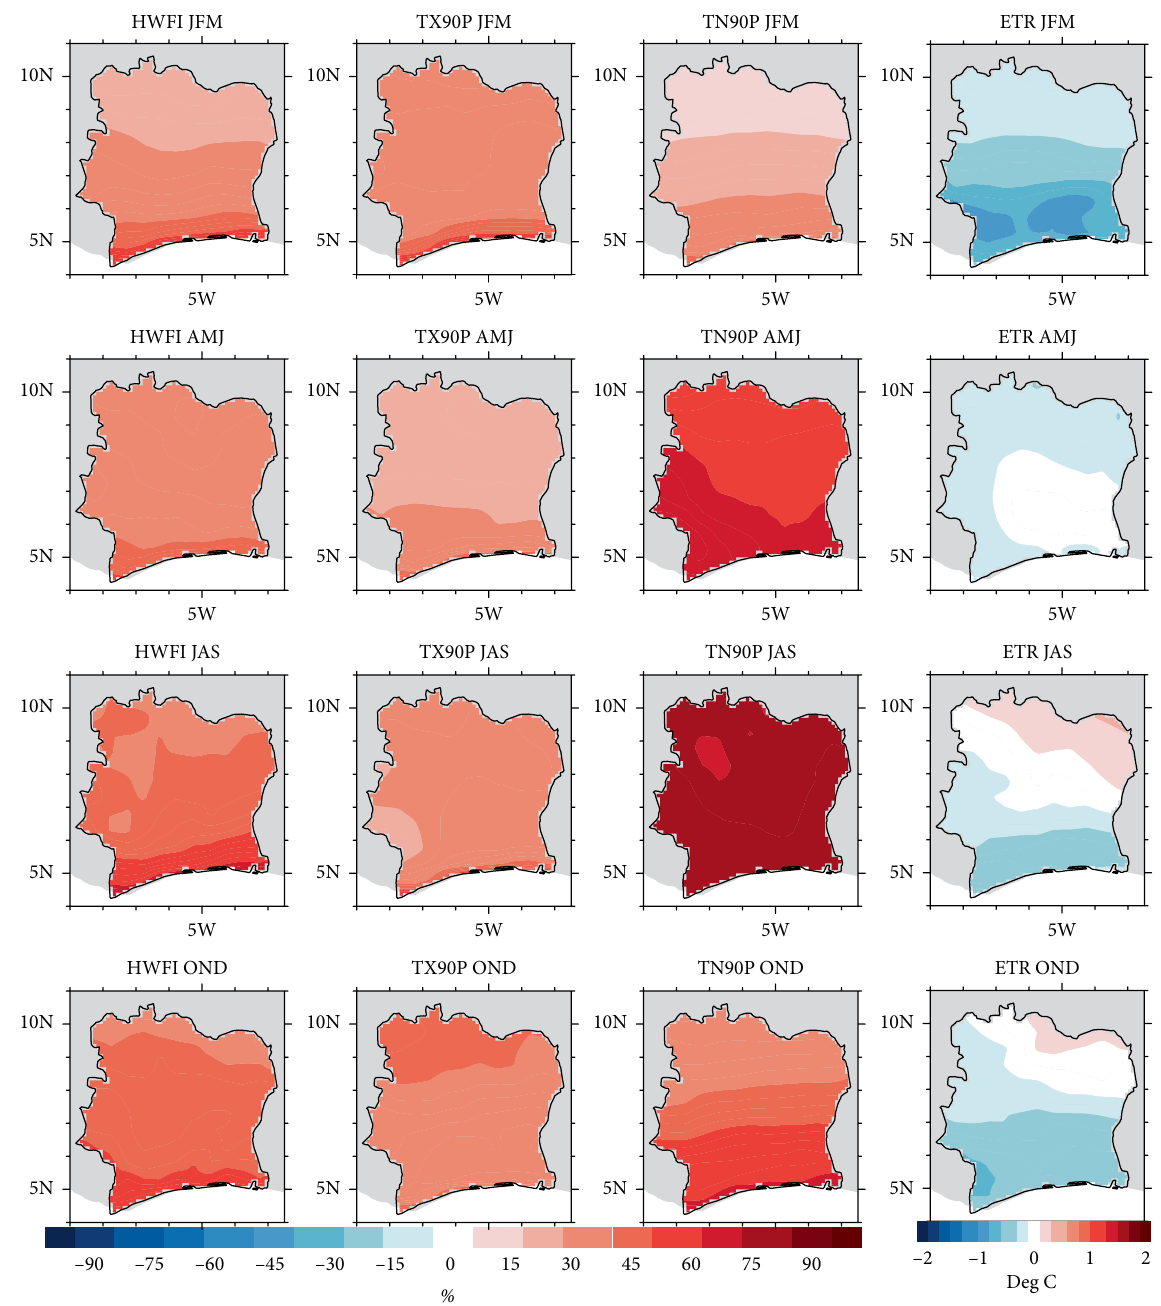
Figure 4: Seasonal mean changes of the HWFI, TX90P, TN90P, and ETR indices, (RCP4.5 minus Historical) from the multi-model ensemble mean of the CORDEX-Africa simulations over 2031–2060 (a) and 2071–2100 (b)